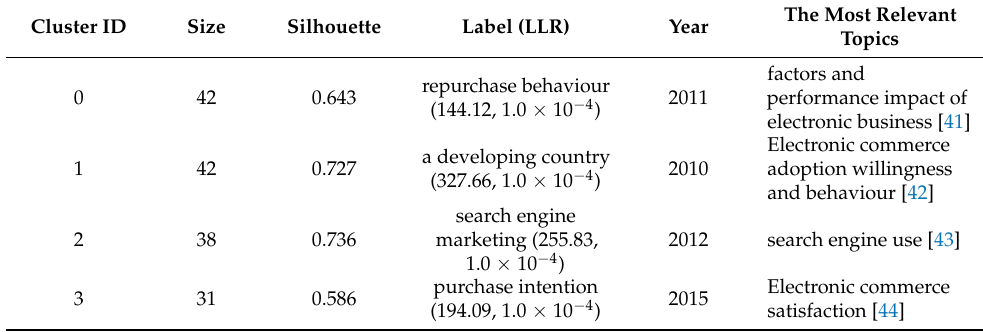
Table 5. Most relevant topics in electronic commerce by clusters.